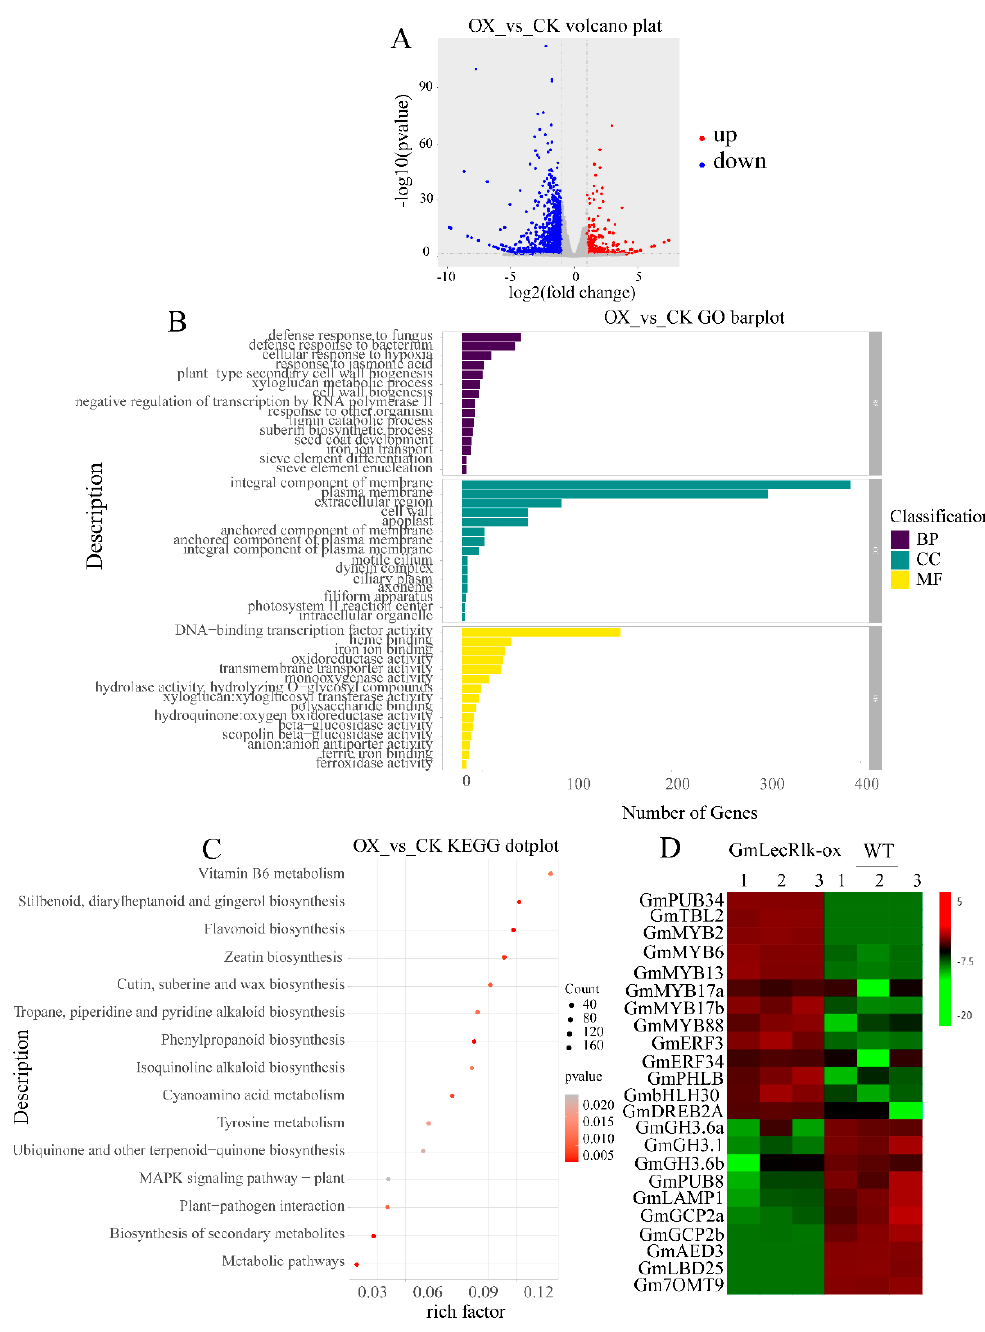
Figure 5. Transcriptomic analysis of GmLecRlk-ox and WT soybean. ( A ) Number of genes showing differential expression in GmLecRlk-ox and WT; ( B ) GO terms that were statistically enriched in differentially expressed genes in GmLecRlk-ox and WT; ( C ) KEGG enrichment analysis of differentially expressed genes in GmLecRlk-ox and WT plants; ( D ) The heat map of differential expression in GmLecRlk-ox and WT soybean. The numerical values for the green-to-red gradient bar represent the log2-fold change relative to the control